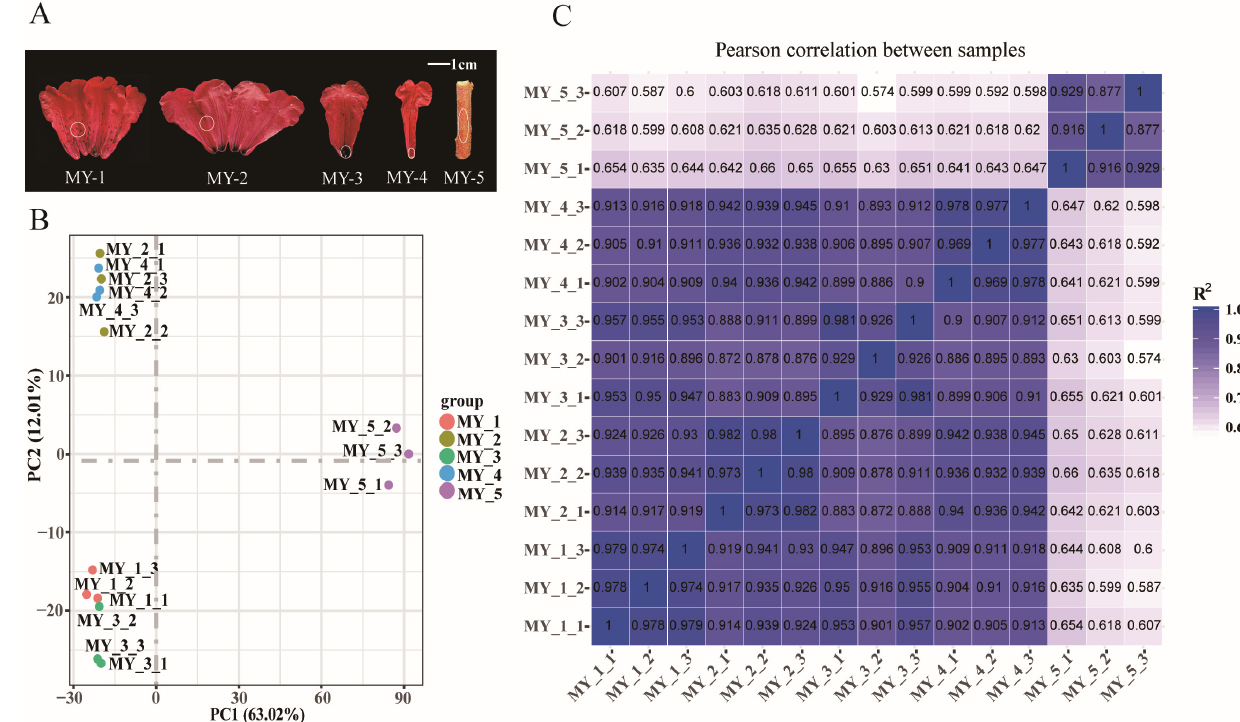
Figure 5 . Cis-acting elements in the MYB promoter region of Rhododendron delavayi . ( A ) MYB gene promoter region regulatory elements. Boxes of different colors represent various cis elements and are distributed in different positions among 184 MYB genes. Axes represent gene length. (B) Statistics of cis elements in MYB promoter involved in plant growth and development, phytohormone response, and abiotic stress response.